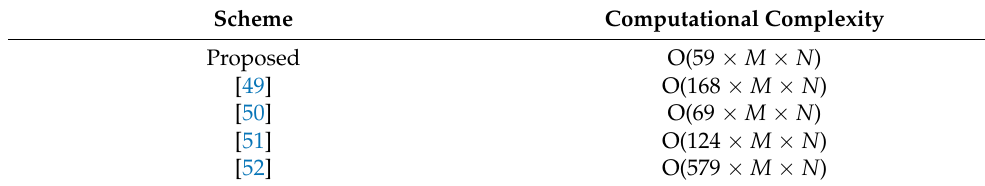
Table 12. Comparison based on computational complexity.